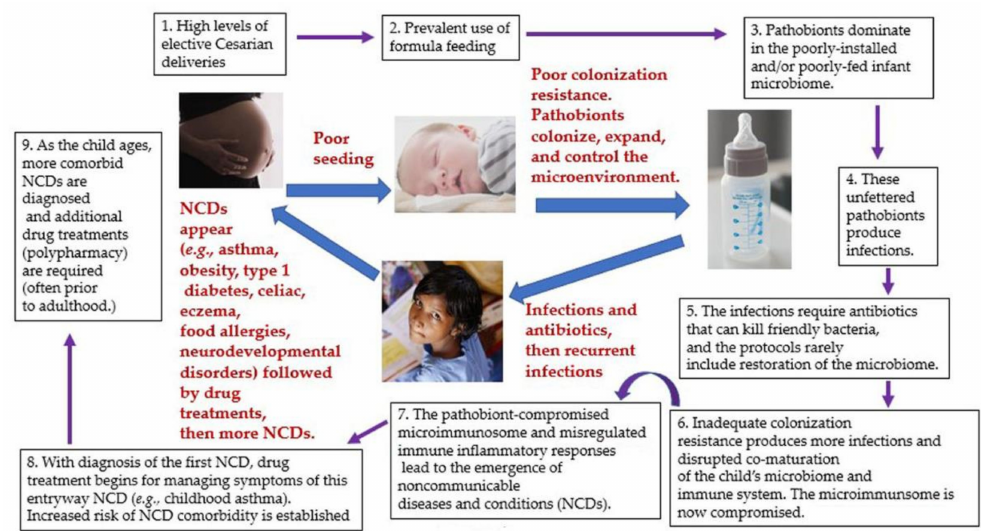
Figure 1. Lack of focus on the microbiome promotes a pathobiont-dominated microbiome, a damaged microimmunosome, misregulated inflammation, and the likelihood of multimorbid NCDs over the